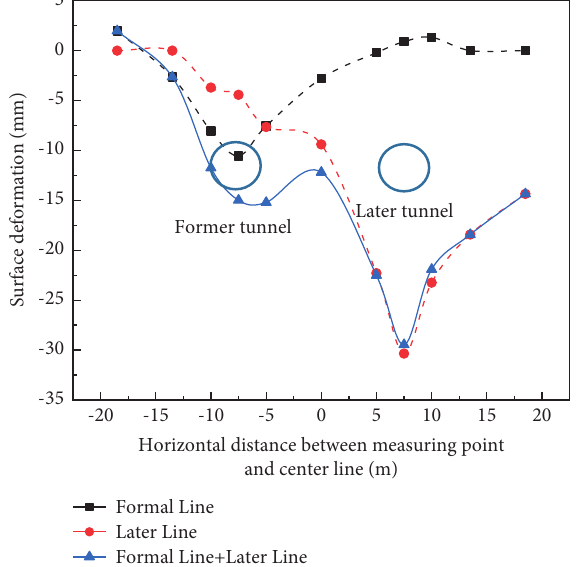
Figure 4: Surface deformation of section DBC26.